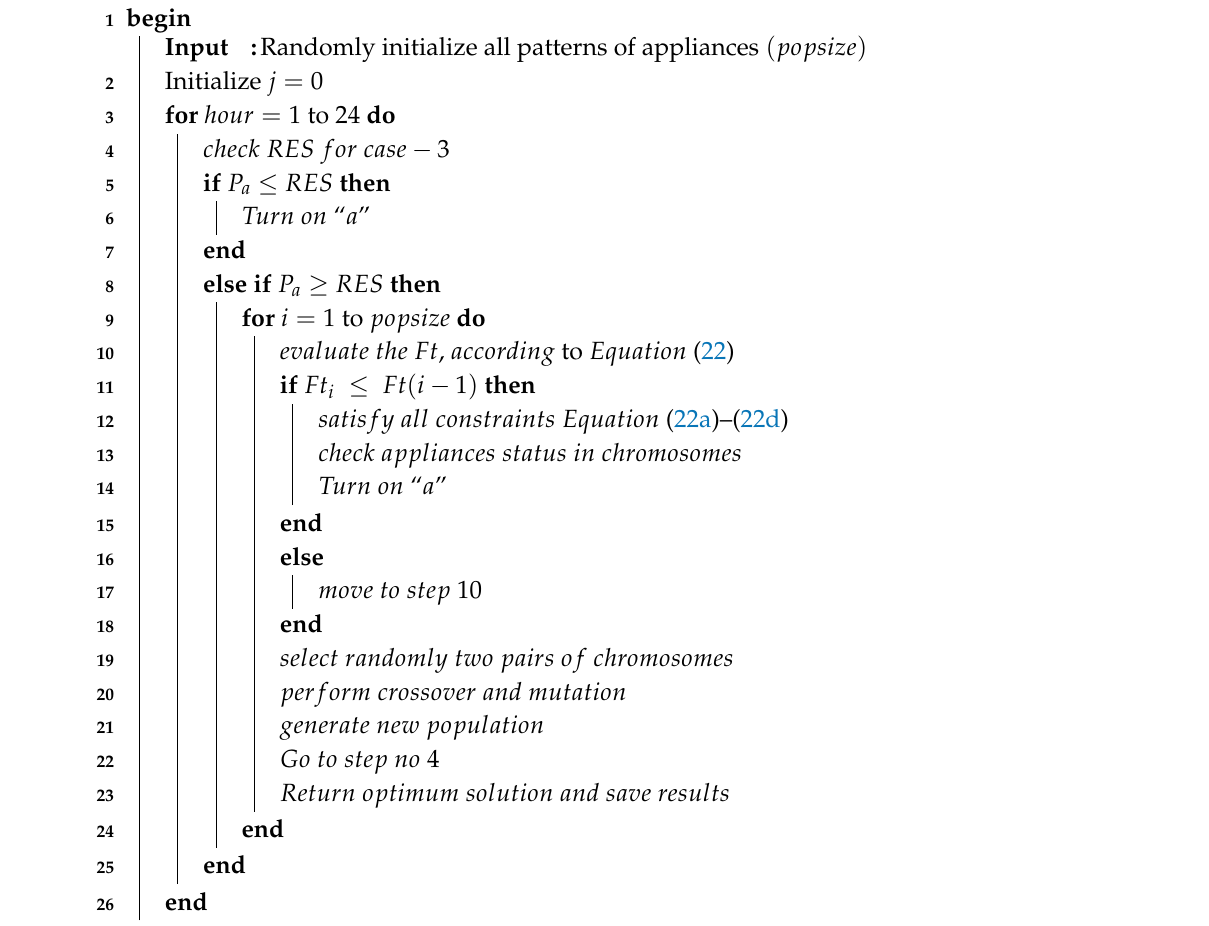
Algorithm 1: The proposed load scheduling optimization